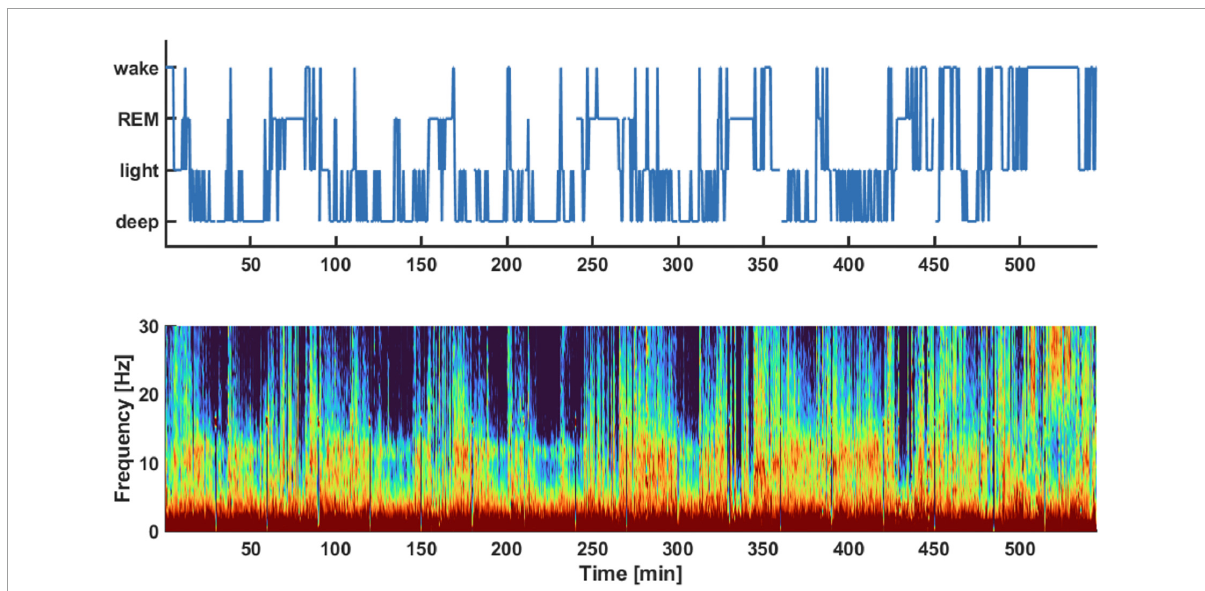
FIGURE1 Exemplary hypnogram (Top) and density spectral array (Bottom) of the pre-aerobics intervention EEG recording session. The hypnogram on top shows the different vigilance states the subject transitioned throughout the night. These sleep stages were derived from the spectral information provided in the density spectral array. The auto staging details of the sleep profiler are described in Levendowski et al. (2017). For example, light sleep was indicated if there was strong activity in the EEG alpha-band around 10 Hz as indicated by red colors in this frequency range.